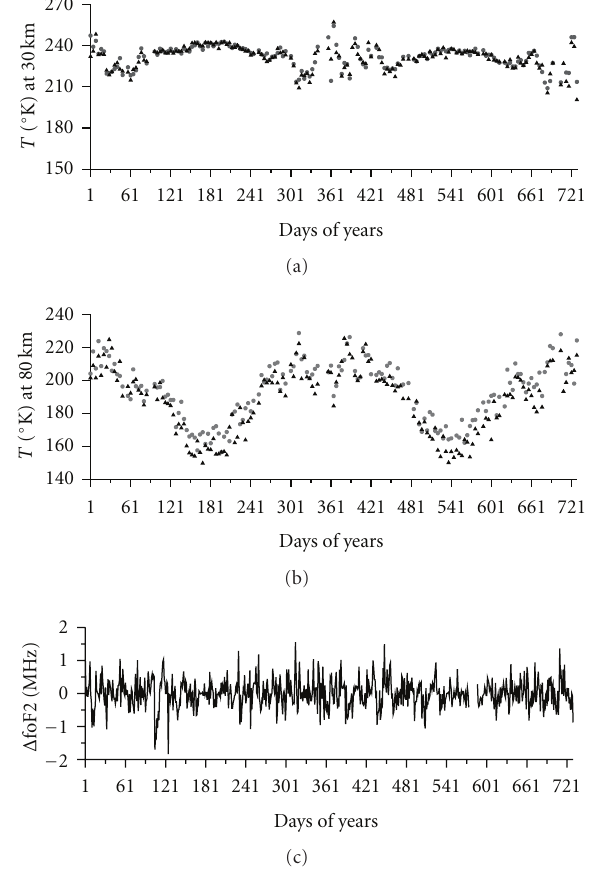
Figure 2: The distribution of temperature during 2006-2007 at heights of 30km (a) and 80km (b) over Irkutsk: grey circles—day temperature, triangles—night temperature and deviations of foF2 from median, concerning local midnight (c).